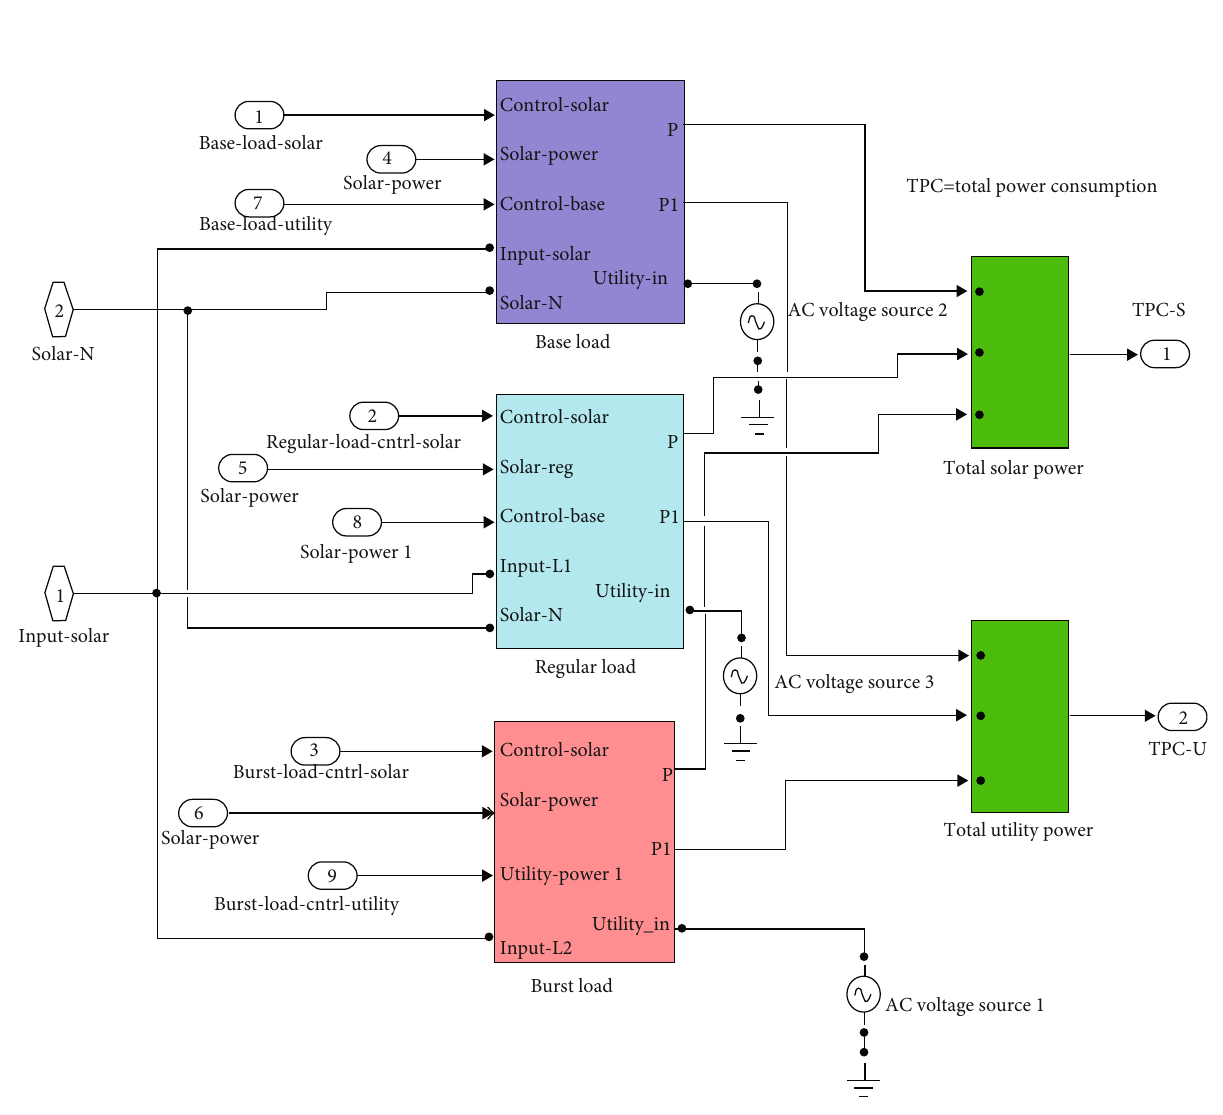
Figure 23: Load priority model for proposed